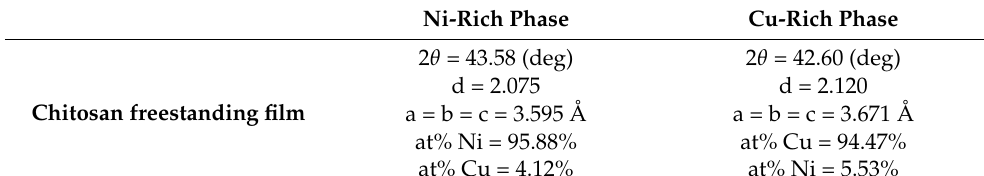
Figure 9. Chitosan film ( a ) hanging on electrode, ( b ) being attracted by a magnet. 4. Conclusions We report a novel electrodeposition method of CuNi-chitosan freestanding film based on micelle collapse and coordination of chitosan with the metal ions generated in situ by concurrent chemical oxidation. In particular, this novel synthetic process is trig- gered by the coordination of chitosan with metal ions generated in situ by the controlled CuNi surface dissolution of the suspended metallic NPs with the acidic plating bath. The entrapped CuNi NPs have a Cu-rich phase and a Ni-rich phase. Due to the Cu-rich phase being more corrosion-resistant, the Ni-rich phase is more involved in the chitosan coordi- nation process. The obtained chitosan freestanding film has smooth and homogeneous morphology, magnetic properties, and adequate strength to be peeled off of the elec- trodes. Using this method, robust MCFF with a variety of shapes and large surface area can be readily built up. Author Contributions: J.B.: methodology, software, investigation, formal analysis. Y.A.: conceptu- alization, methodology, data curation. X.W.: investigation, methodology. M.Z.: investigation, meth- odology. J.Z.: writing—original draft, review and editing, conceptualization, supervision, funding